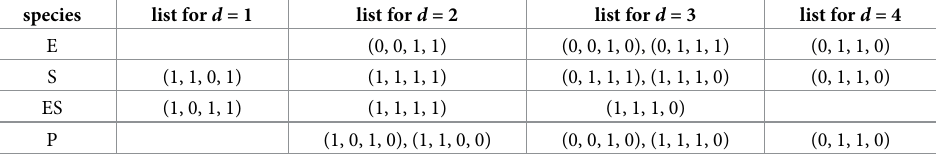
Table 3. List of transitions for each species that make up the network pathways sorted by their Hamming distance d to the steady state (1, 0, 0, 1). Note, that a state can reach the steady state in multiple ways. It is therefore possible to have the same initial assigned to multiple species. species list for d = 1 list for d = 2 list for d = 3 list for d = 4 E (0, 0, 1, 1) (0, 0, 1, 0), (0, 1, 1, 1) (0, 1, 1, 0) (1, 1, 0, 1) (1, 1, 1, 1) (0, 1, 1, 0) ES (1, 0, 1, 1) (1, 1, 1,